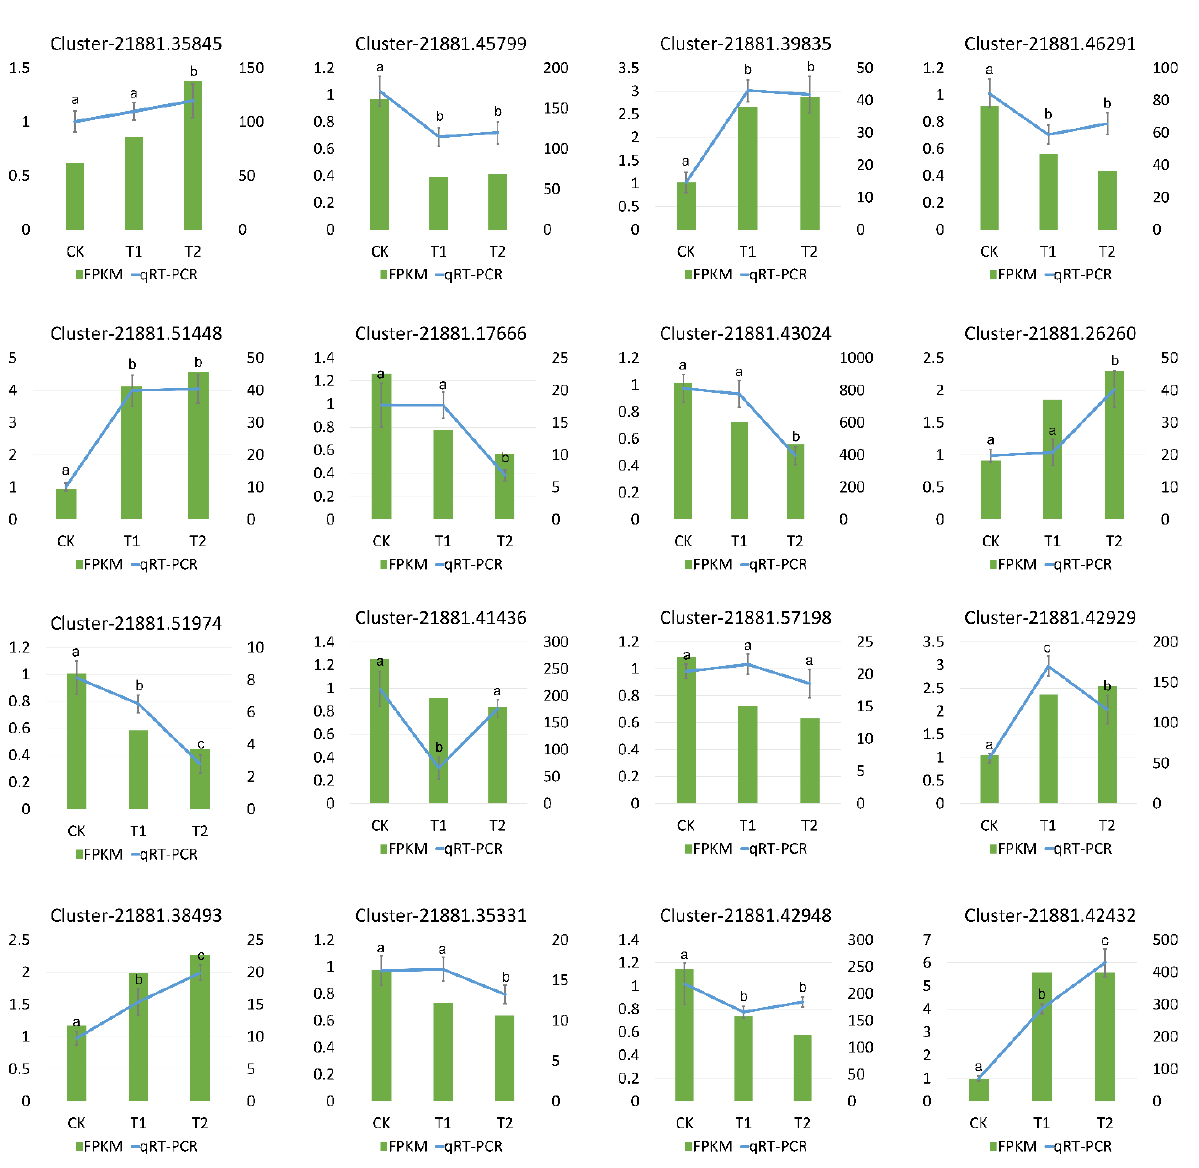
Figure 8. qRT-PCR validation of 16 DEGs involved in heat response in Michelia macclurei . The x-axis is the three samples, and the y-axis shows the FPKM by RNA-Seq (right) and the relative quantitative expression level by qRT-PCR (left) for each unigene.